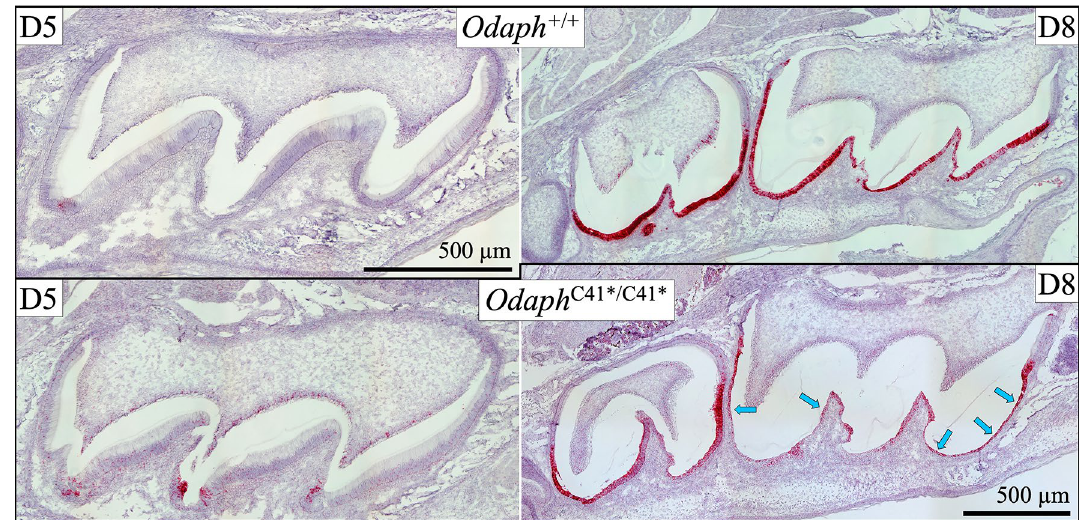
Figure 5. Klk4 Expression in Odaph +/+ and Odaph C41*/C41* D5 and D8 Maxillary First Molars. On Day 5, positive in situ hybridization for Klk4 expression was observed in some odontoblasts and in the enamel free zone near the cusp tips of both Odaph C41*/C41* and Odaph +/+ maxillary first molars. On Day 8, after enamel development had progressed into the early maturation stage, positive Klk4 mRNA signal was specifically observed in transition and maturation ameloblasts of wild-type first and second molars, with spotty signal in odontoblasts. A similar pattern was observed in D8 Odaph C41*/C41* maxillary molars but with decreased intensity (arrows) in the flattened ameloblasts lining the expanded, cyst-like enamel space. This Klk4 expression pattern, although diminished relative to the wild-type, supports the interpretation that the flattened epithelial cells lining the cyst were